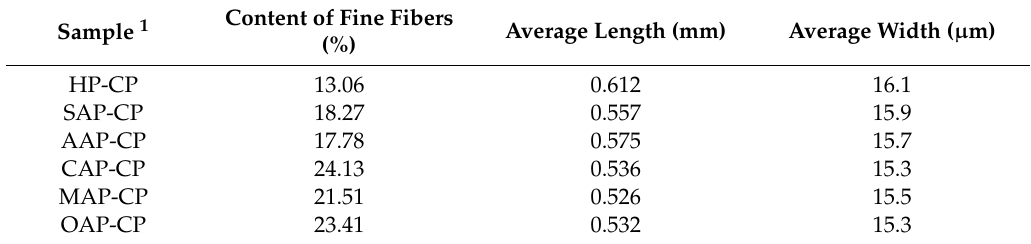
Table 5. Chemical pulp fiber quality analysis.